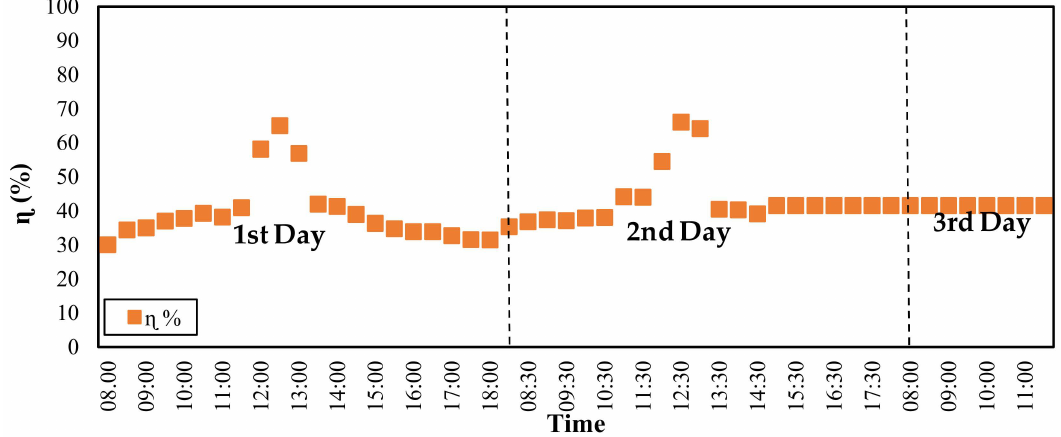
Figure 7. Variation of thermal e ffi ciency ( η ) values with